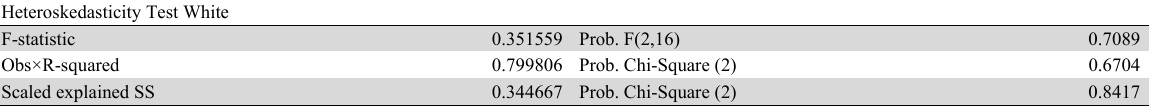
Heteroscedasticity test Heteroskedasticity Test